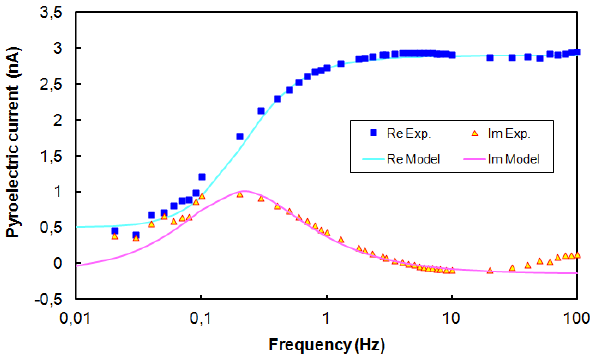
Figure 1. Pyroelectric current spectrum of a PZT plate in compari- son to a fit to Eq. (5).